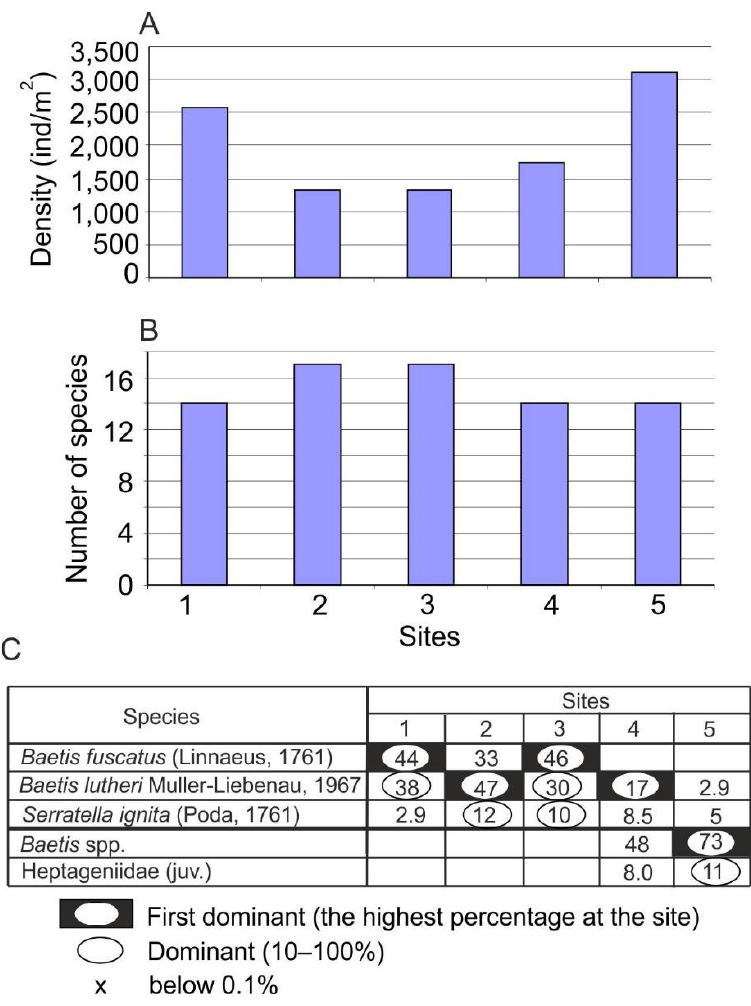
Figure 6. The density ( A ), number of species ( B ), and percentage of dominant species ( C ) of Ephemeroptera in the Dunajec River in 1992 – 1993 (sites 1 – 3) and 1999 (sites 4 – 5) (according to [18,26], modified).